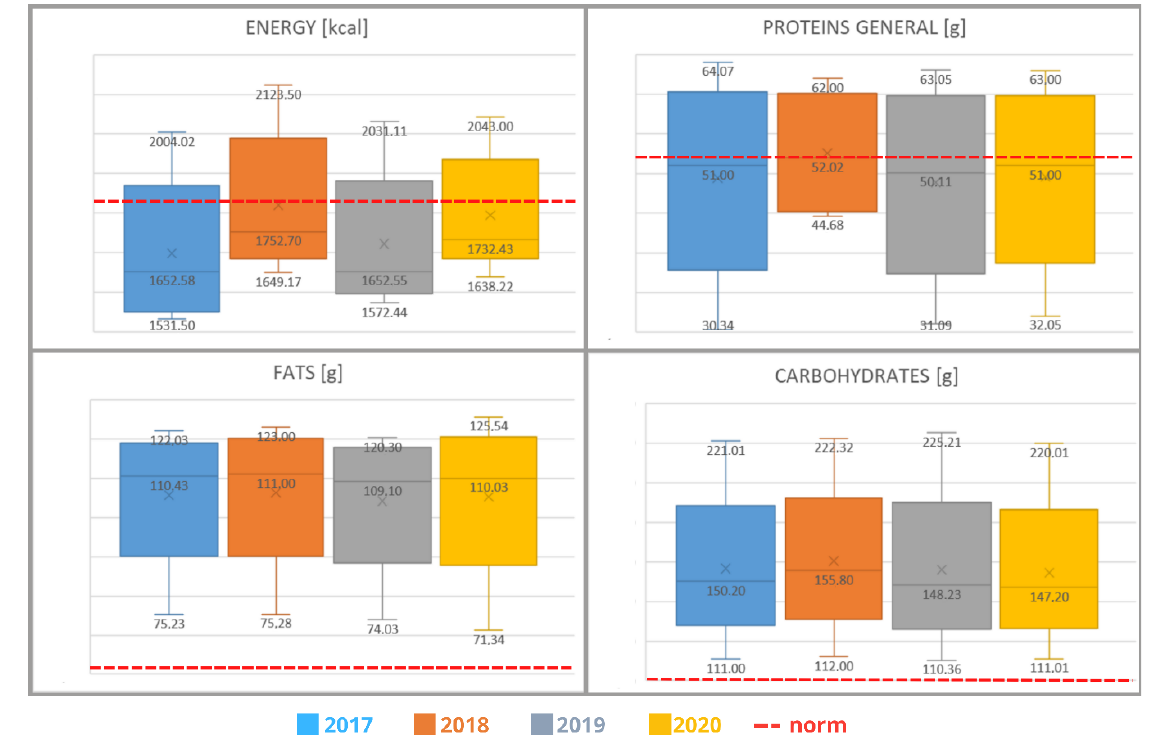
Figure 2. The content of selected nutrients in decade menus. Table 3. The content of selected vitamins and minerals in assessed menus (daily